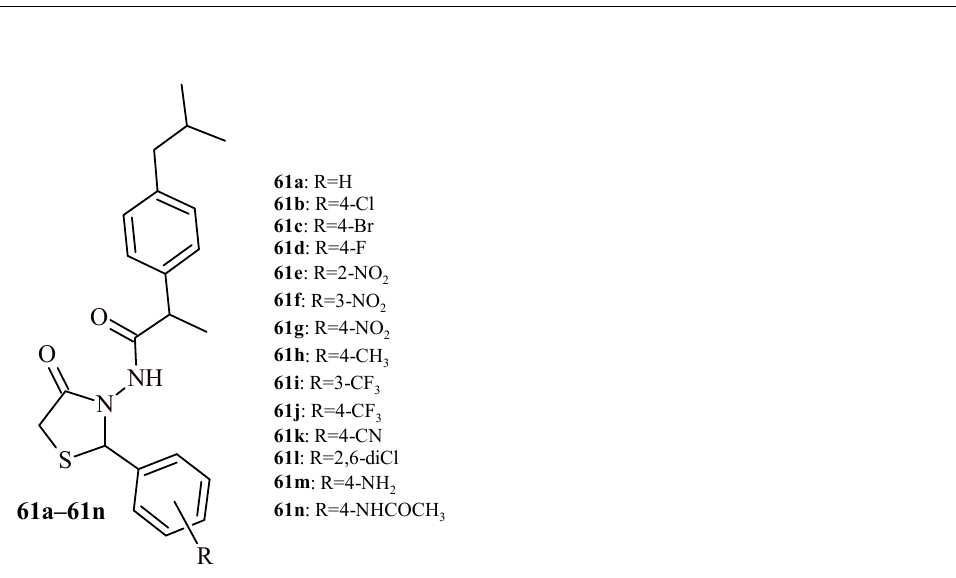
Figure 25. Ibuprofen-thiazolidin-4-one hybrids with anti-inflammatory and analgesic activities. The highest analgesic activity in tail-flick assay showed Compounds 61m (75.67 ± 5.94%),